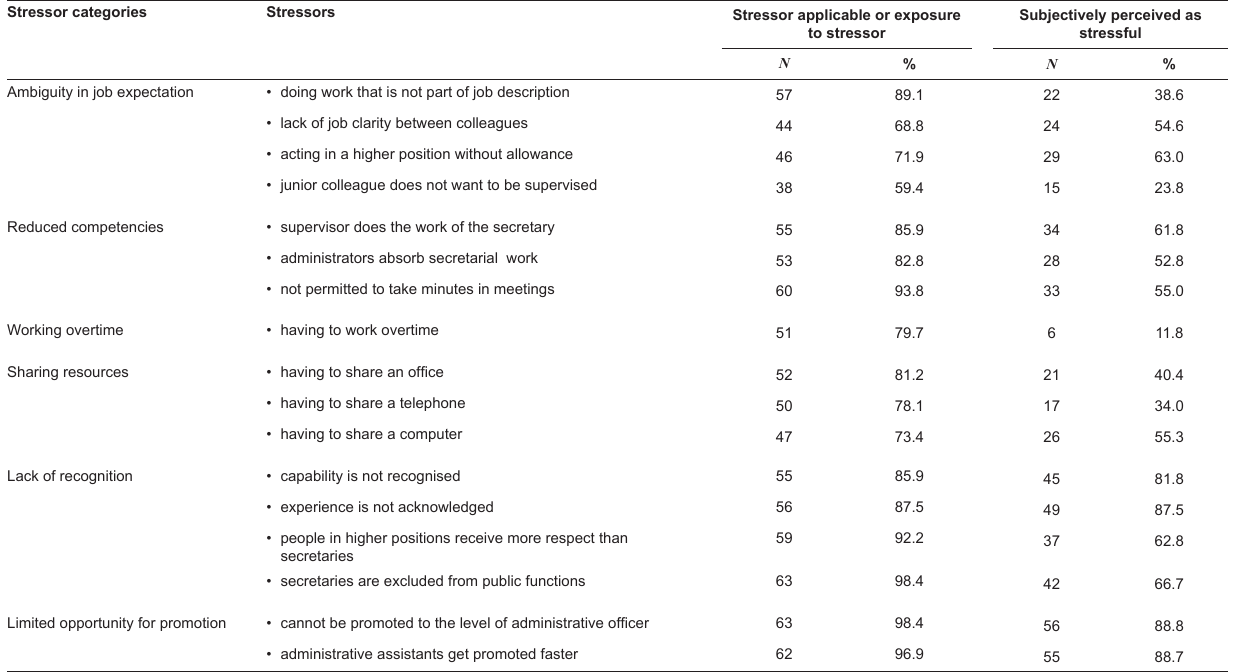
TABLE 1 Potential stressors and subjective stress